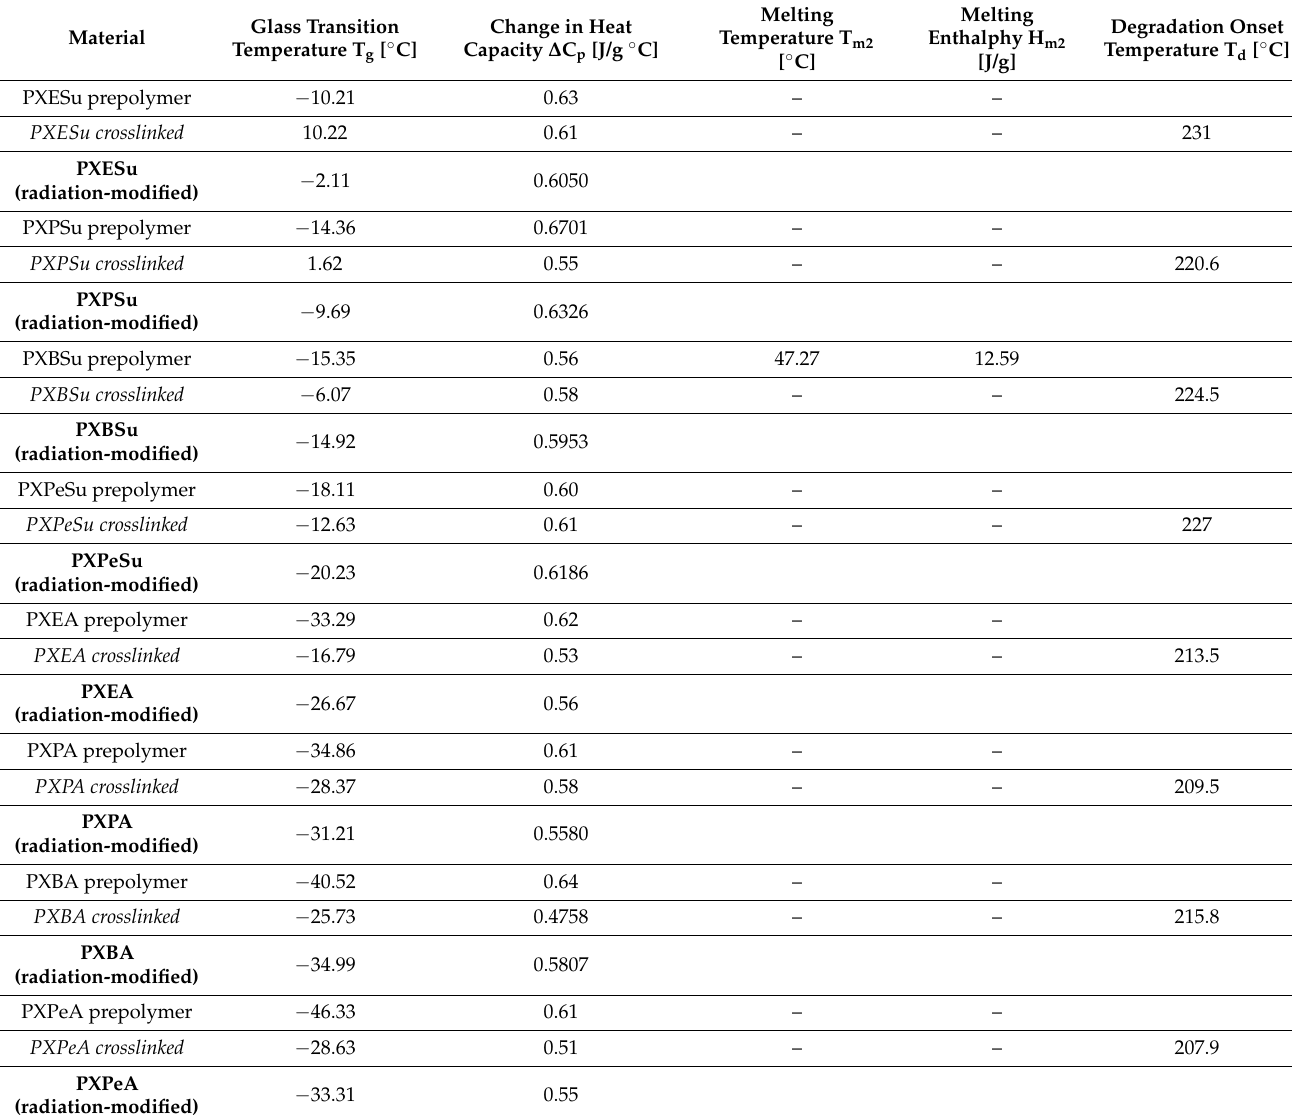
Table 2. DSC termograms of poly (xylitol dicarboxylate-co-diol dicarboxylate) before and after